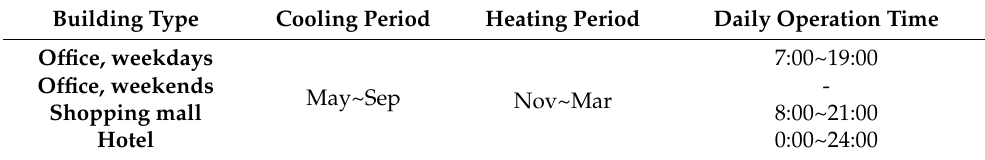
Table 5. Operation time for cooling and heating